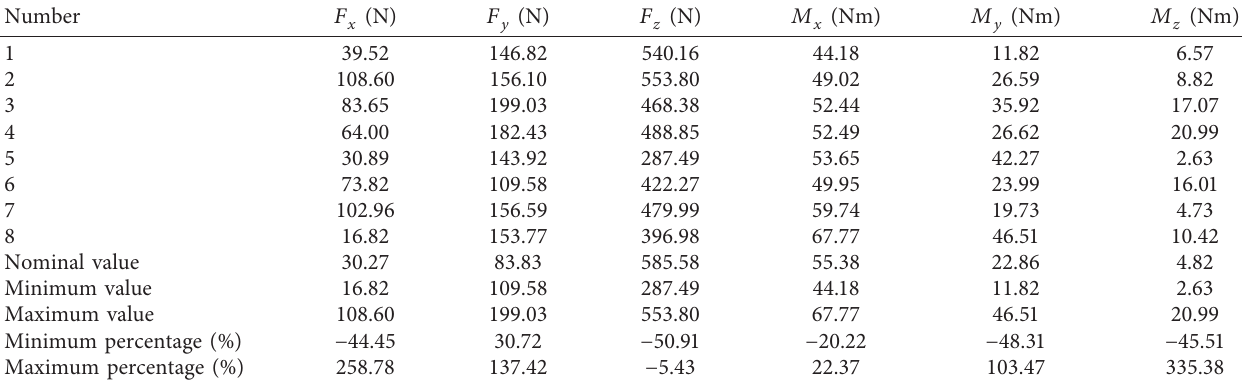
Table 8: The identified forces under the random values of the mount acceleration phase at the engine